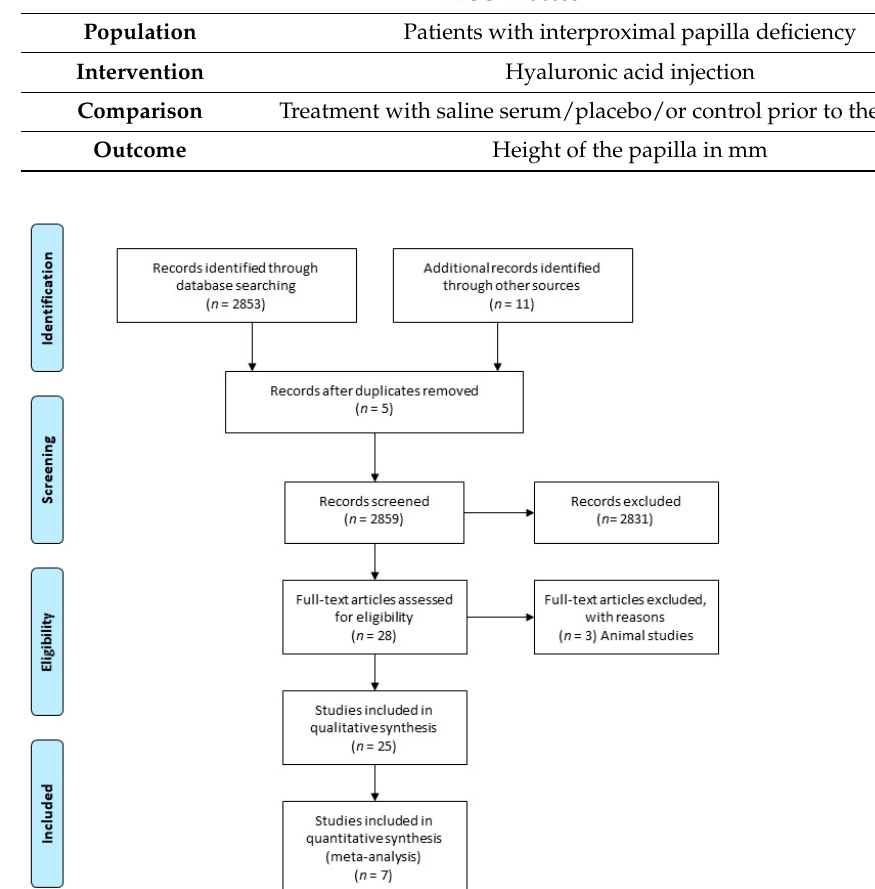
Table 1. Parameters used for PICO (P—patient, problem or population. I—intervention. C— comparison, control, or comparator. O—outcome(s)).